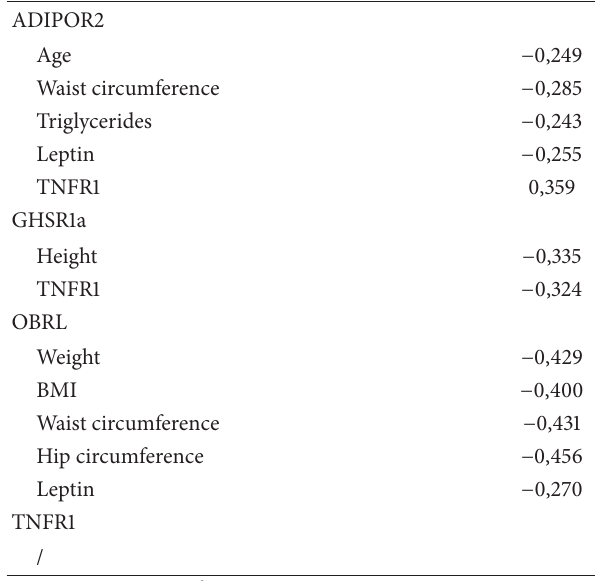
Table 3: Correlations of adipokine and ghrelin receptors with all other parameters investigated in the study. Only significant correlations with the respective 𝑟 coefficient are reported ( 𝑃 < 0.05